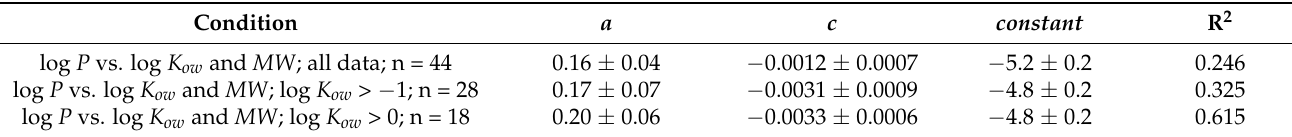
Table 3. Regression analysis results of log P with log K ow and MW as independent variables, using the data of pH independent permeants and then with the conditions of log K ow > − 1 and >0. The parameters are defined in Equation (11). The values presented are the least squares means and standard errors of the